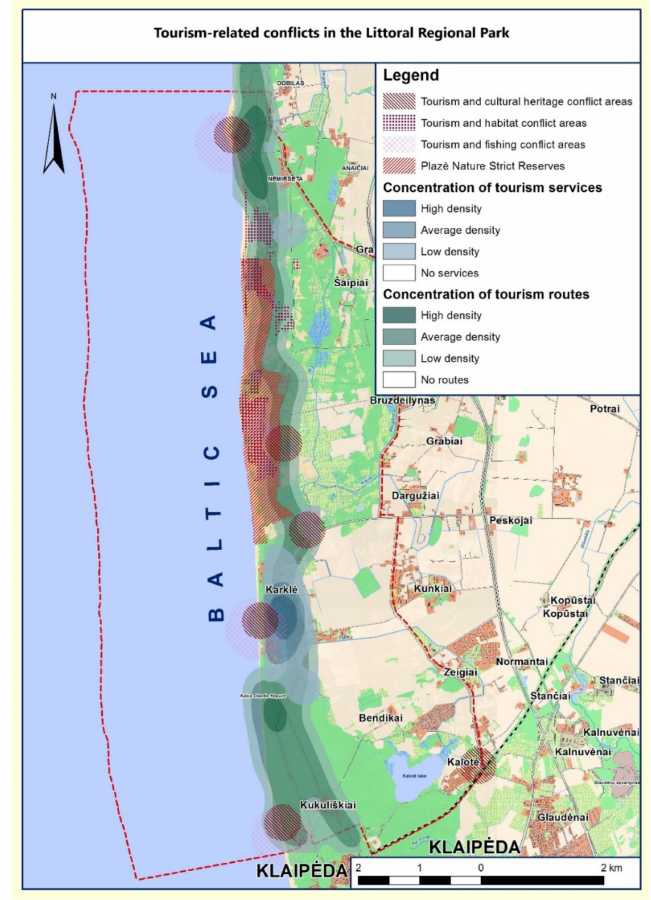
Figure 7. A GIS map of tourism-related conflicts the Littoral Regional Park (plotted by Egidijus